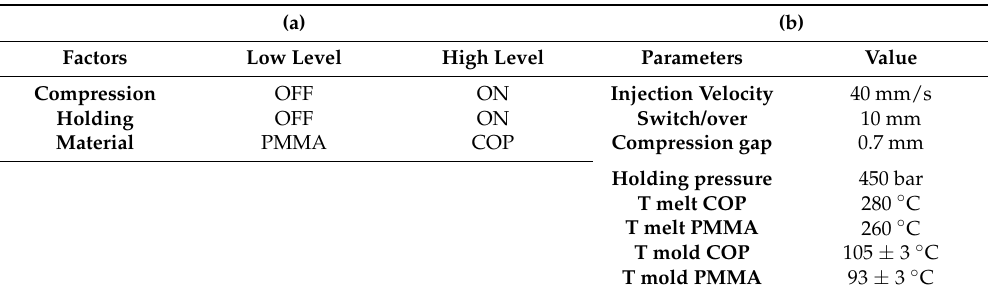
Table 4. Screening experiments investigating the effect of compression and holding phases as independent process stages of IM and ICM for PMMA and COP materials: ( a ) with three factors on two levels; ( b ) constant parameters.